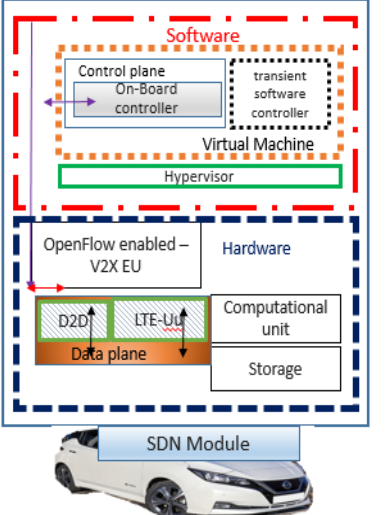
Figure 3. Software defined on-board wireless vehicle